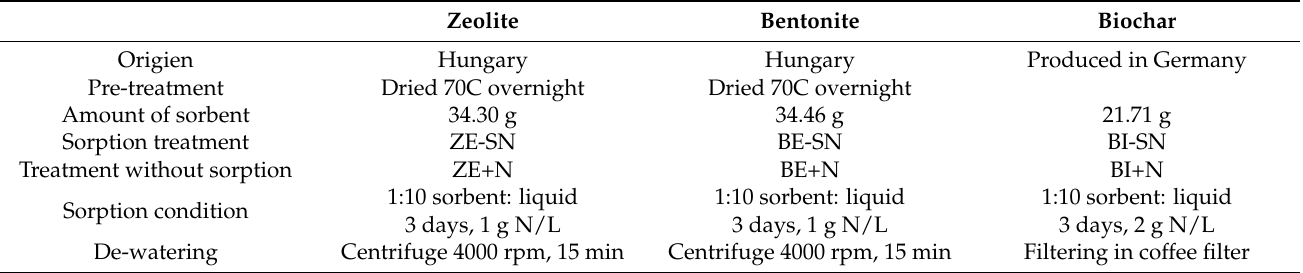
Table 1. Sorbents and sorption treatments used. Treatment without sorption means sorbent and N both applied separately to the